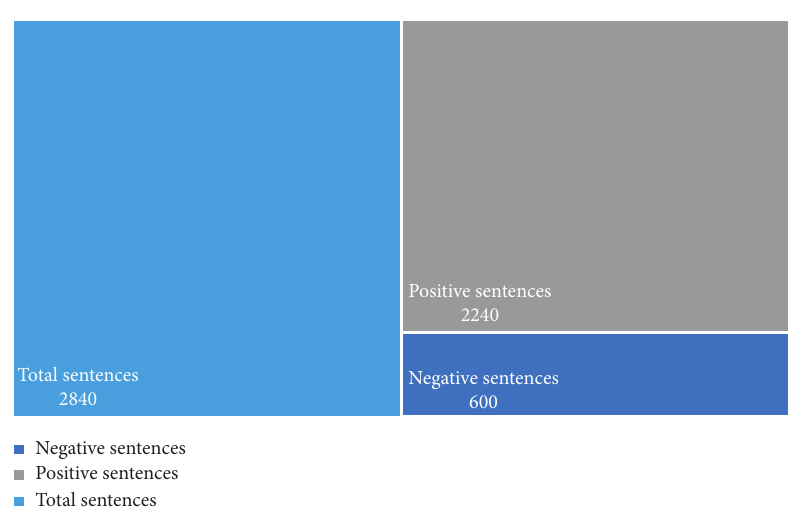
Figure 2: Positive and negative sentence distribution of the dataset utilized in this